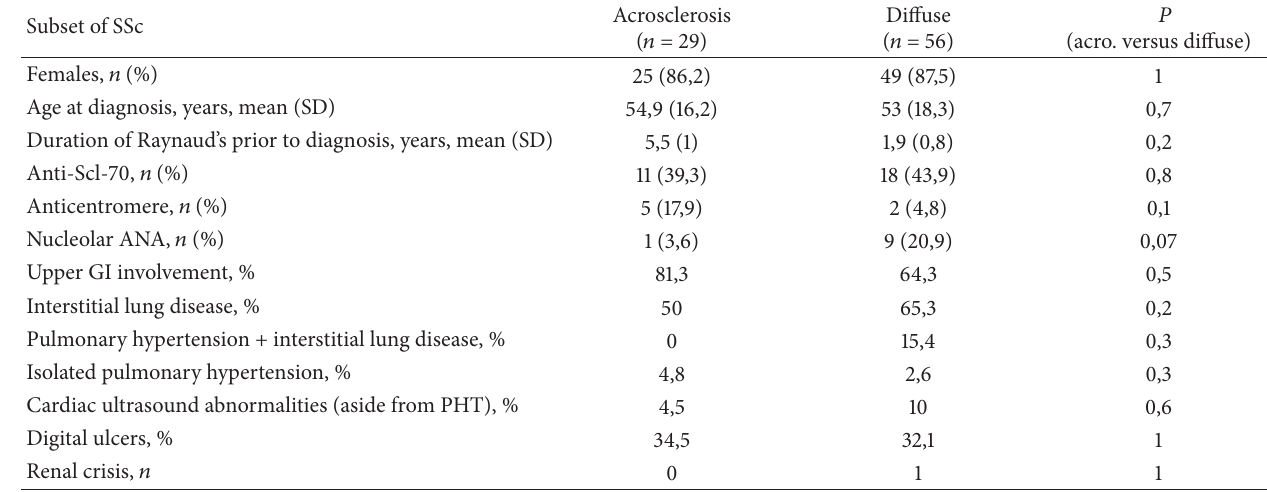
Table 2: Clinical and serological profiles comparing acrosclerosis and diffuse